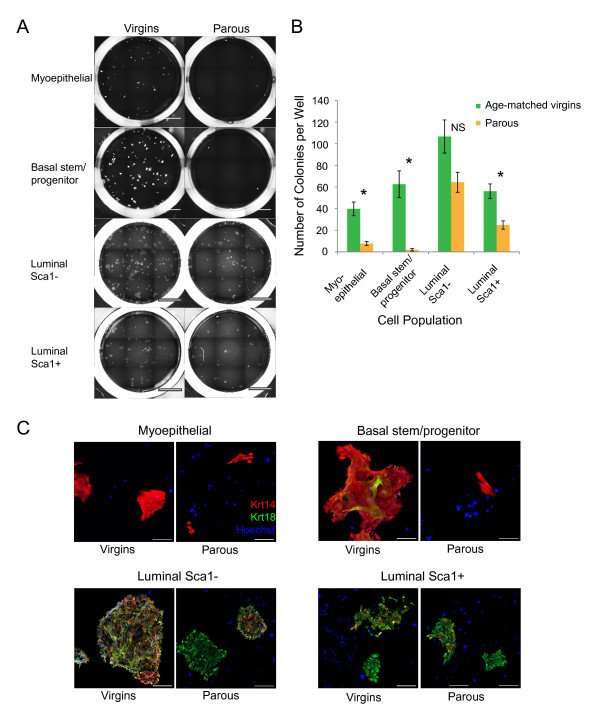
Parity reduces the progenitor potential of mammary epithelial cell subpopulations. (A) Representative images of individual wells with colonies formed by the specified cell subpopulations from age-matched virgin and parous mice. Scale bar, 4 mm. (B) Bar graph comparing the colony-forming capacities of myoepithelial cells, basal stem/progenitor cells, luminal Sca1-, and luminal Sca1+ cells of age-matched virgin and parous mice. Data are from three independent experiments and represent the mean ± SEM of colonies per well; 18 wells were assessed per cell type. *P < 0.015, NS: not significant (P = 0.08), by using two-tailed unpaired Student t test. (C) Representative images for the immunophenotyping of 5-day-old colonies grown from myoepithelial cells, basal stem/progenitor cells, luminal Sca1-, and luminal Sca1+ cells. The colonies were stained for luminal Krt18 (green) and basal Krt14 (red) expression. Hoechst 33342 (blue) was used to distinguish nuclei and to label feeder cells (negative control). Scale bar, 200 μm.